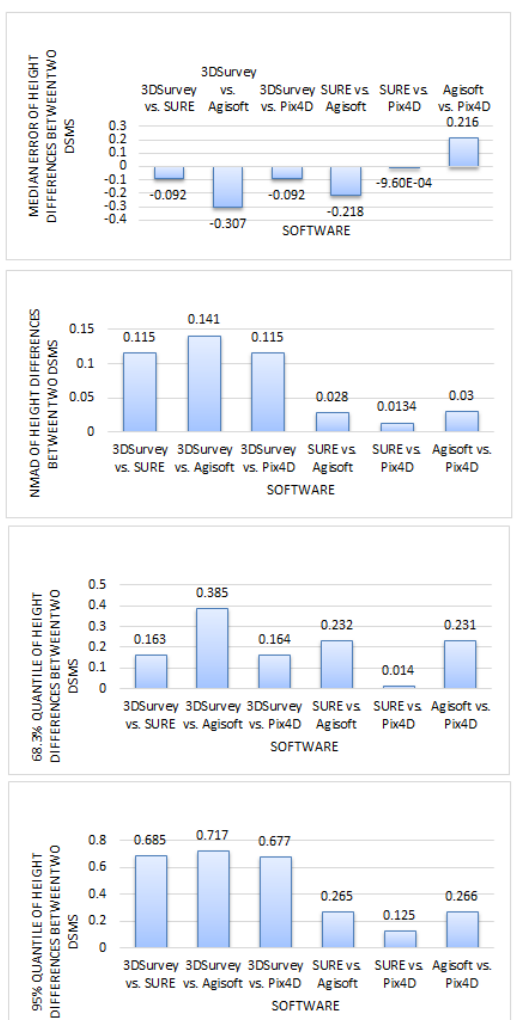
Figure 10. Robust measures for accuracy assessment of two DSMs: First: the median error (m), Second: NMAD (m), Third: 68.3% quantile (m), Forth: 95% quantile (m)